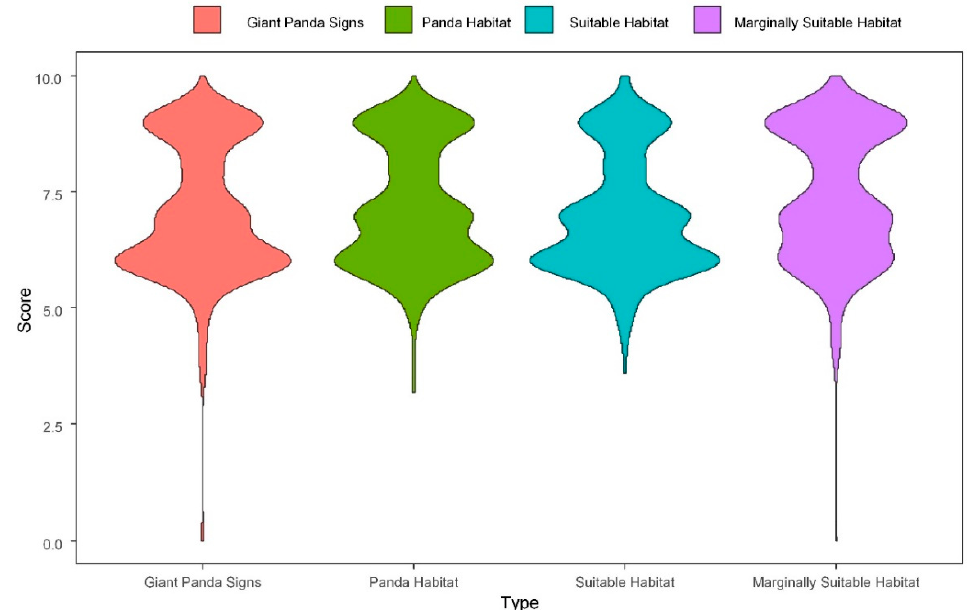
Figure 9. The ecological intactness characteristic of giant panda signs, giant panda realistic habitat, giant panda suitable habitat, and marginally suitable habitat.